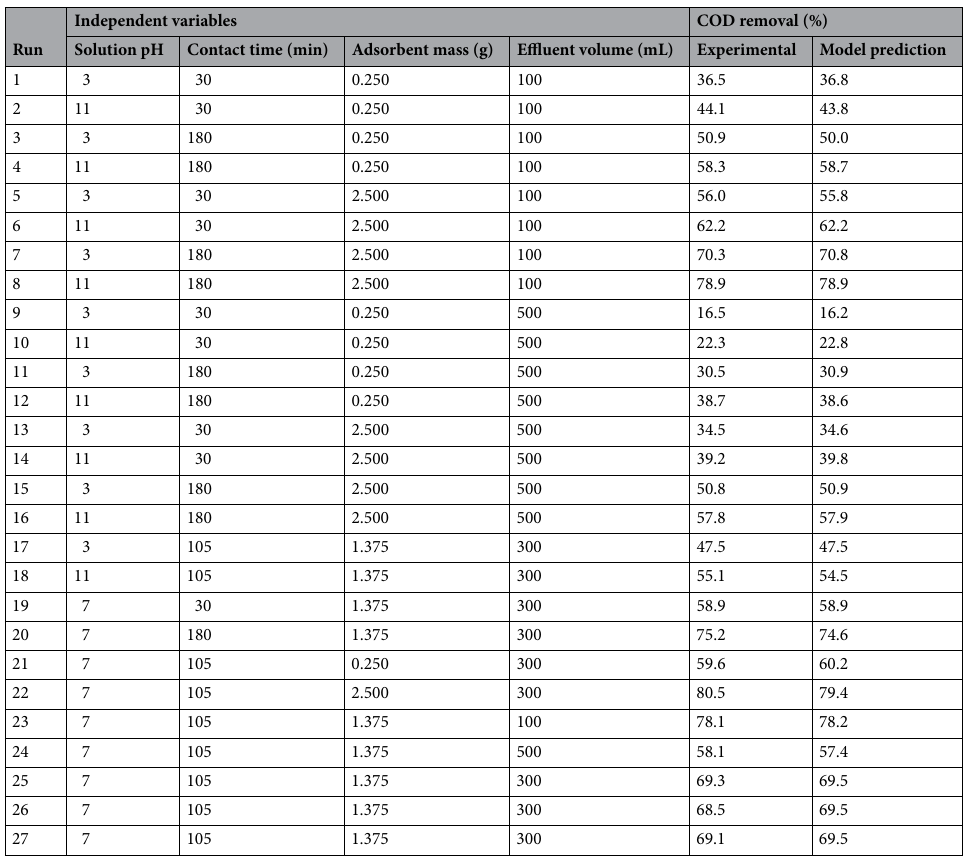
Table 1. Summary of the design of experiment, experimental and predicted COD removal